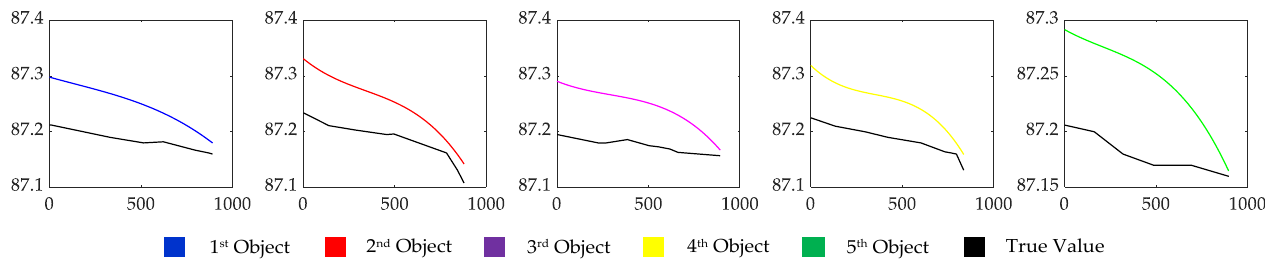
Figure 13. Comparison of the planar position between the measured and mapped trajectories in which the ordinate is X (m), and the abscissa is Y(m).